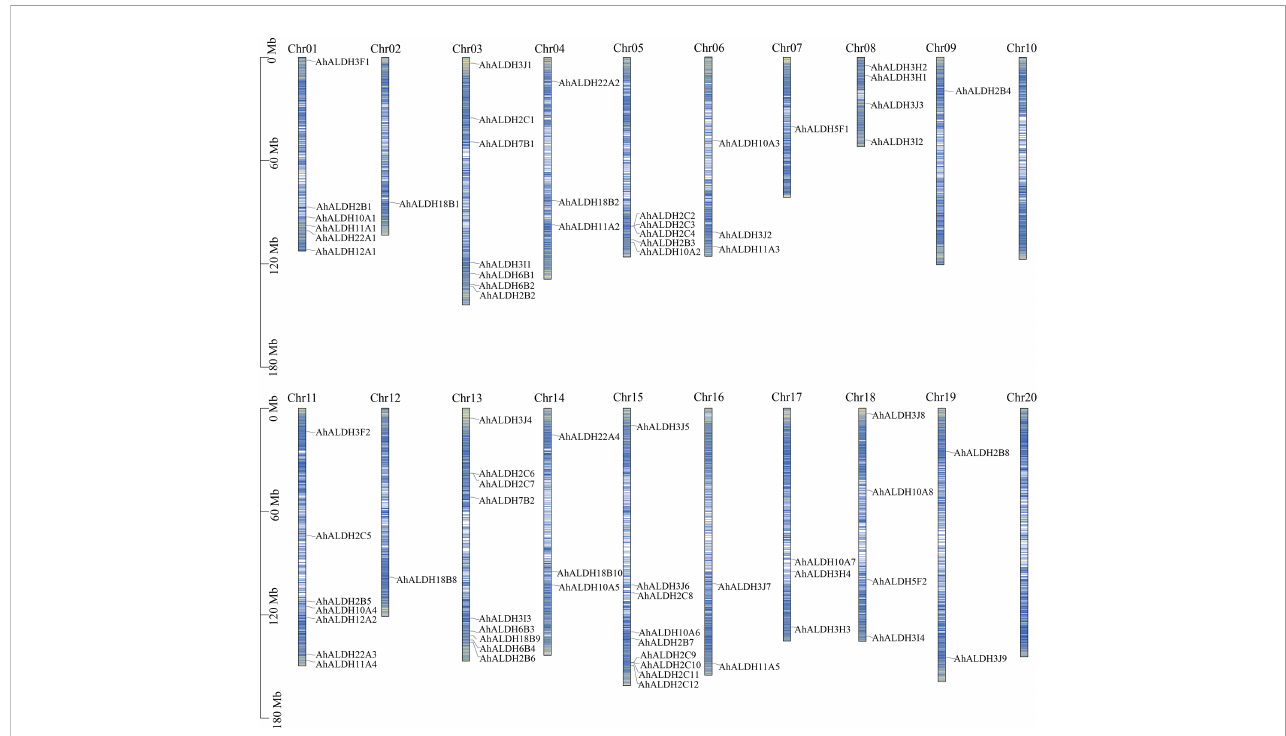
FIGURE 2 Location of AhALDH members on chromosomes (Chr1 – Chr20). The length of the columns represents the size of the chromosomes. The black scale on the left represents the position, and blue lines inside the columns represent the gene density on